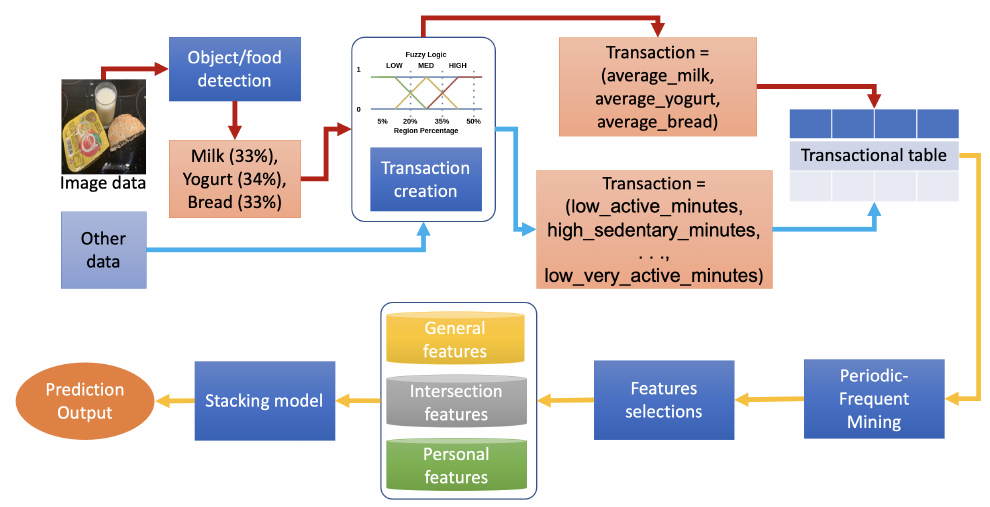
Figure 1. The method’s overview. Table 1. Overview of the PMData dataset